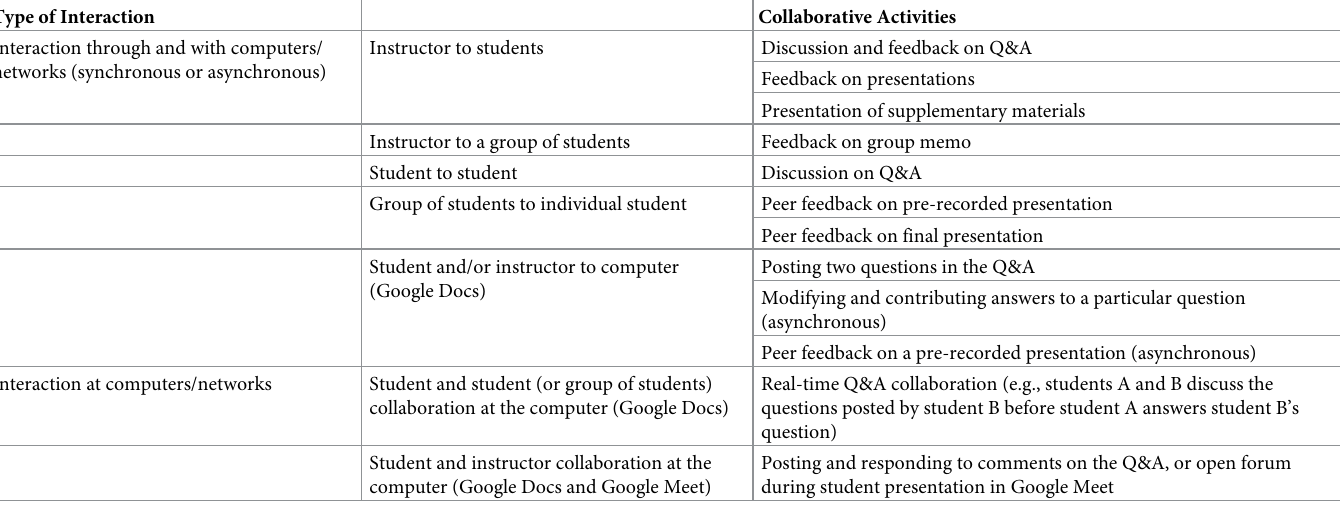
Table 3. Some interaction patterns during collaborative activities (adapted from [9,